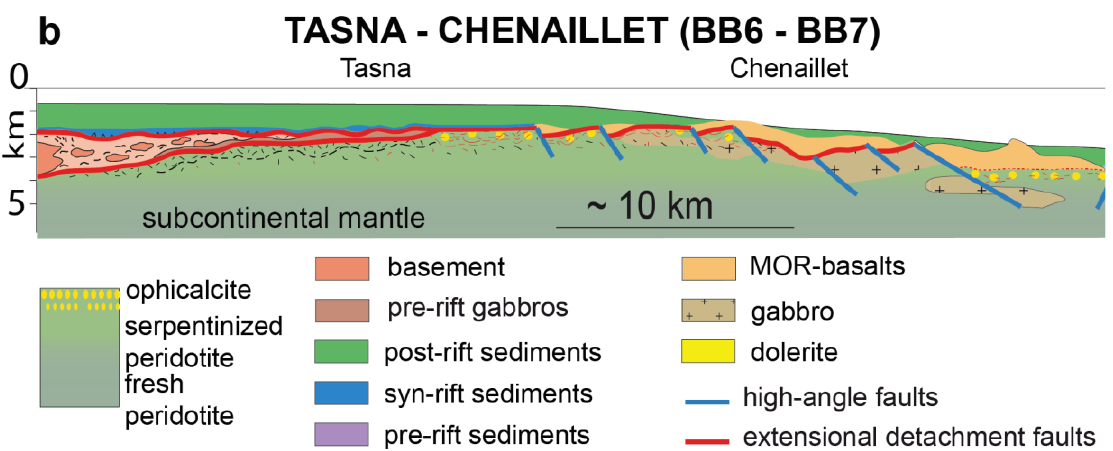
Figure 7. Examples of BB5, BB6 and BB7 in the Western Alps: ( a ) The Acceglio and Col du Longet outcrops display Jurassic sediments directly over basement and/or mega-breccia bodies, which are here interpreted as characteristic of a distal margin (BB5 and/or BB6); Figure modified from [121] see text for details and discussion); ( b ) The Tasna Nappe is consensually recognized as preserving an ocean – continent transition (OCT) between thinned continental crust and exhumed mantle, and thus was regarded as a BB6 by [19]. The Chenaillet ophiolite displays remnants of an embryonic seafloor spreading system, and thus was regarded as a BB7 by [19]. Figure modified from [100].